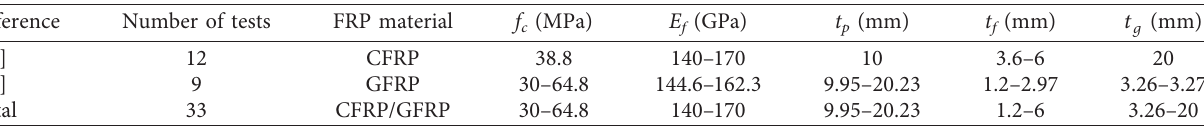
Table 6: Database under the concrete surface failure